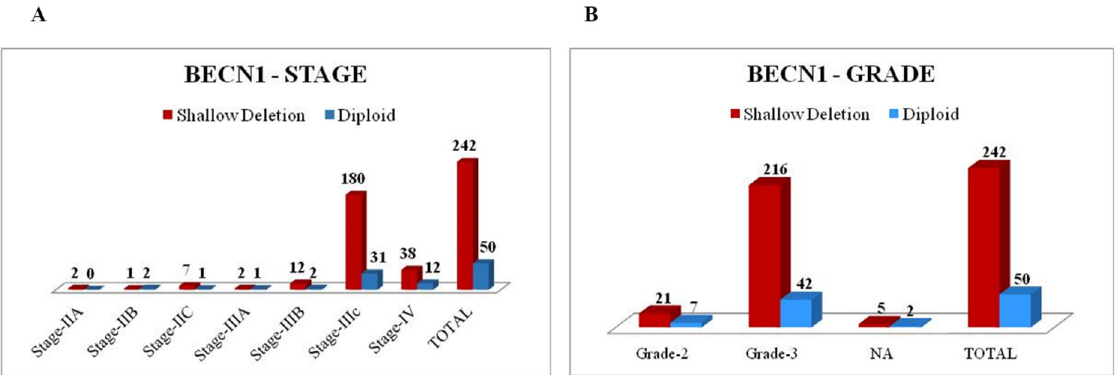
Figure 3. Shallow deletion of BECN1 and BRCA1 correlates with stage IIIC and grade 3 in ovarian cancers. ( A ) Graph representing the distribution of BECN1 copy number variation (CNV) according to tumor stage. ( B ) Graph representing the distribution of BECN1 CNV according to tumor grade. ( C ) Graph representing the distribution of BRCA1 CNV accord- ing to tumor stage. ( D ) Graph representing the distribution of BRCA1 CNV according to tumor grade. 3.6. Correlation of BECN1 and BRCA1 Co-deletion In the 316 ovarian cancers in TCGA, BECN1 and BRCA1 were shallow (monoallelic) deleted in 242 (76.6%) and 240 (76%) cases, respectively (Supplementary Table S1). A co- occurrence analysis of CNV revealed that the two events were highly correlated (Supple- mentary Table S3), which was expected given the close proximity of these two genes on chromosome 17q21. Out of 316 cases, CNV was identical for both BECN1 and BRCA1 in 313 cases (50 diploid, 240 shallow deletion, 23 amplification), while 2 cases with BECN1 shallow deletion were associated one with amplification and one with deep deletion of BRCA1 , and one case diploid for BRCA1 was amplified for BECN1 (Supplementary Table S3). It is to be noted that no one tumor had a deep (homozygous) co-deletion of both BECN1 and BRCA1 , and only one tumor had a deep deletion of BRCA1 associated with shallow deletion of BECN1 . 3.7. Patients with Shallow Deletion of BECN1 and BRCA1 Have Better Prognosis To determine the prognostic role of BECN1 and BRCA1 , we analyzed the survival of patients bearing a tumor with consistent CNV of the tumor suppressor genes, i.e., with both shallow deletion (240 cases) or diploid (50 cases) status (see Supplementary Table S3). Overall survival and disease-free survival data were not available for 1 (diploid) case and for 51 (16 diploid and 35 shallow deleted) cases, respectively. Based on BECN1 and BRCA1 CNV (diploid versus shallow deletion), it is apparent that patients bearing an ovarian cancer with shallow deletion of the two tumor suppressor genes have a significant better prognosis, i.e., overall and disease-free survival ( p = 0.0105 and p = 0.0364) than the patients bearing a cancer with diploid CNV, independently of the